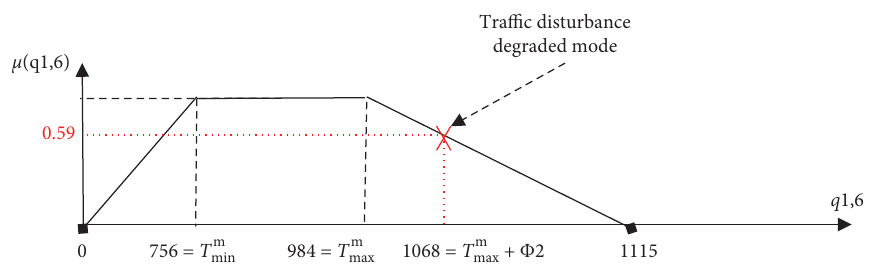
Figure 14: Function of possibility associated with an effective sojourn time ( q